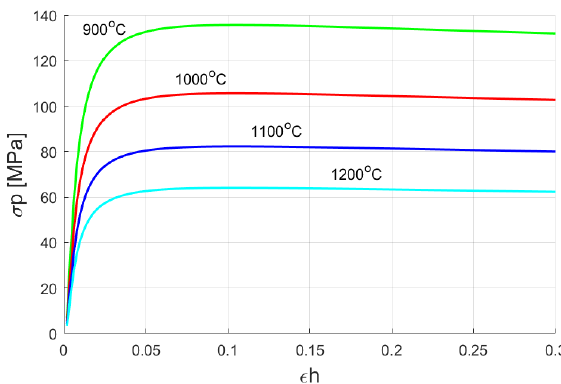
Figure 4: Curves of the predicted hot flow stress σ p as a function of the unit draft ε for different deformation temperatures T and h